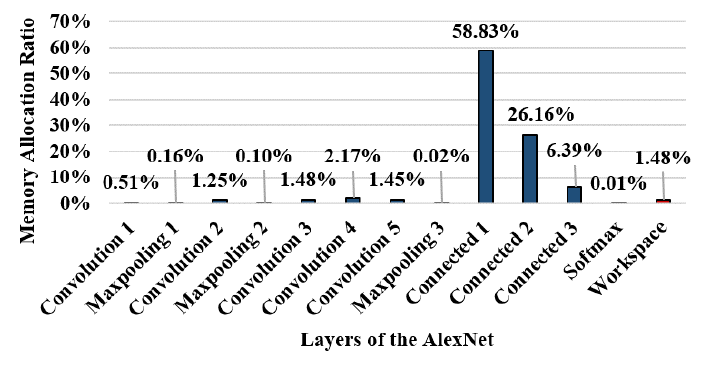
Figure 7. Allocated memory ratio in